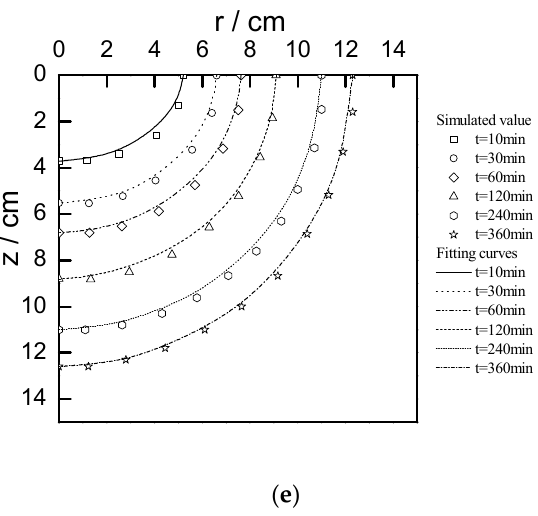
Figure 4. Fitting diagram of wetting front and elliptic curve: ( a ) Experimental results of Xi’an silt loam; ( b ) Simulated results of Xi’an silt loam; ( c ) Simulated results of silt; ( d ) Simulated results of silt loam; ( e ) Simulated results of loam.